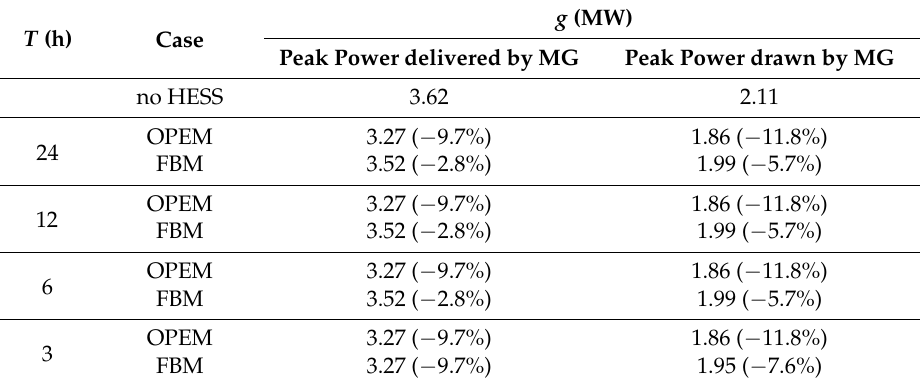
Table 10. Peak shaving weekly performances.